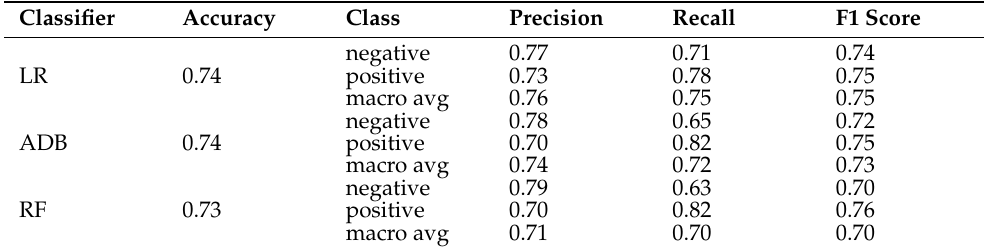
Table 8. Experimental results of ML models with original sentiments using BOW.